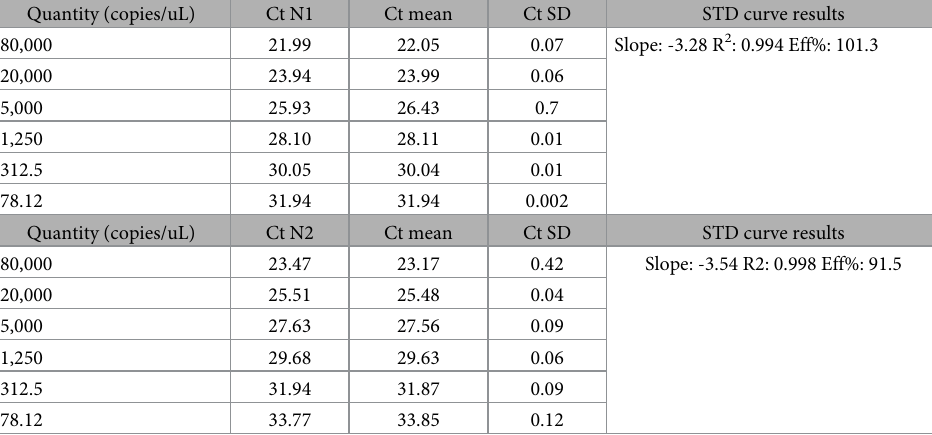
Table 1. Linearity assay of the N gene of SARS-CoV-2. Quantity (copies/uL) Ct N1 Ct mean Ct SD